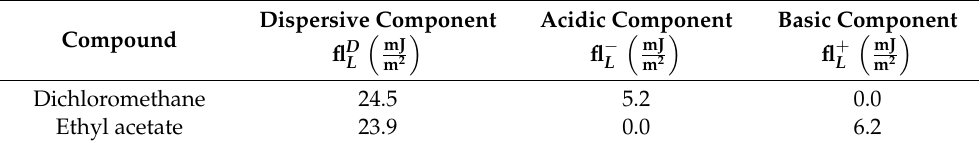
Table 4. Physicochemical data for the test compounds used; L means liquid as DM and EA.